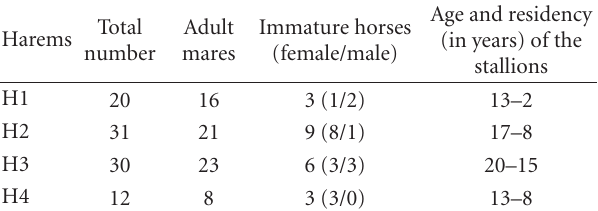
Table 1: Composition, size of the harems, and age and residency of the four